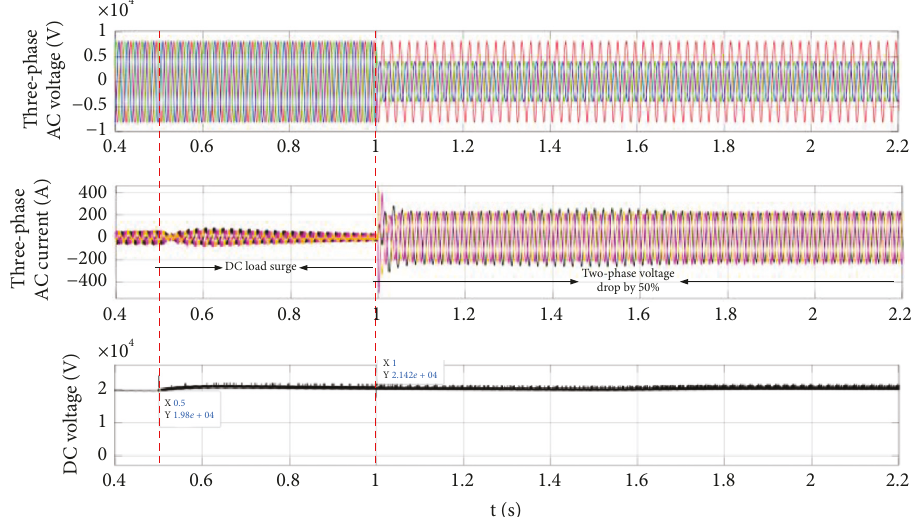
Figure 16: System three-phase voltage/current and DC voltage at 0.4 ∼ 2.2s.